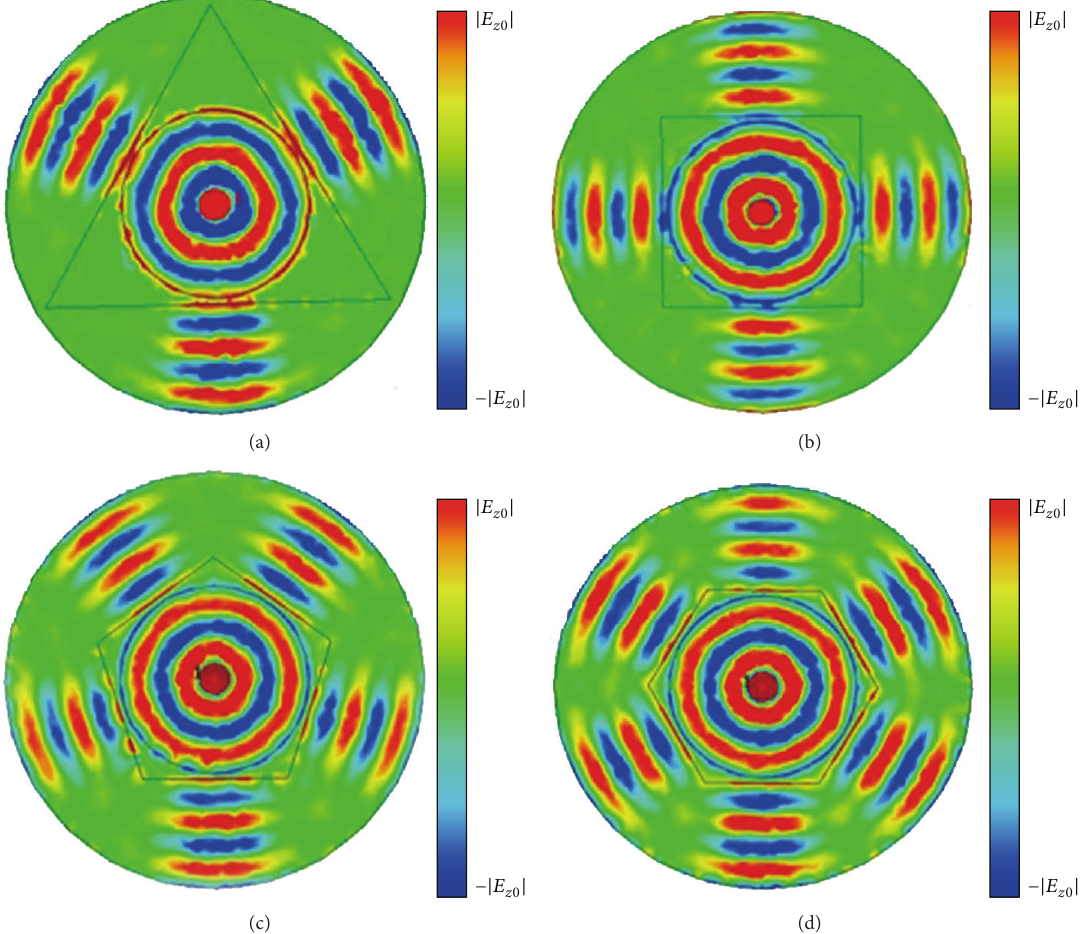
Figure 4: Snapshots of the 𝑧 -component electric field distribution of the TM SPP wave on graphene-based wave splitters with three, four, five, and six beams from (a) to (d),